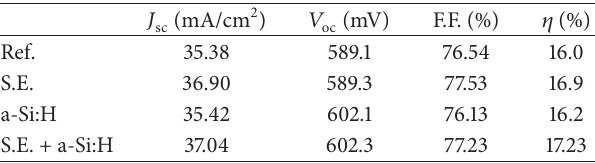
Table 2: Electrical parameters and conversion efficiencies measured forareferencecell(Ref.),aselectiveemittercell(S.E.),aback-surface a-Si:H deposited cell (a-Si:H), and a selective-emitter cell with back- surface a-Si:H deposition (S.E. +